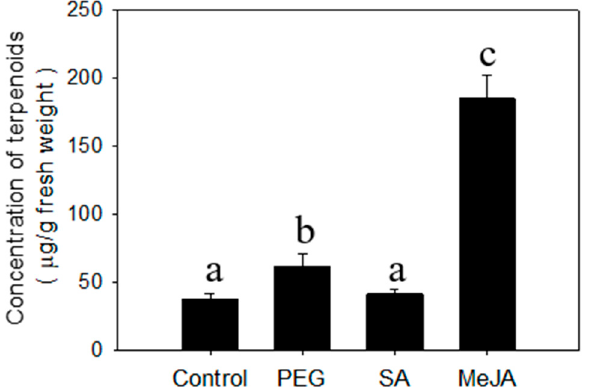
Figure 2. Concentration of total terpenoids from C. iria leaves after treatment with salicylic acid (SA), methyl jasmonate (MeJA), and Polyethylene Glycol 8000 (PEG) treatment. Standard error is denoted for each bar. Different letters (a, b and c) denote significant differences between treatments at P ≤ 0.05 according to an F-protected Tukey’s test.